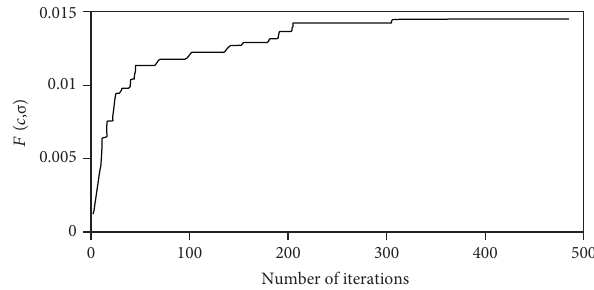
Figure 8: Convergence fi gure of the evaluation function.